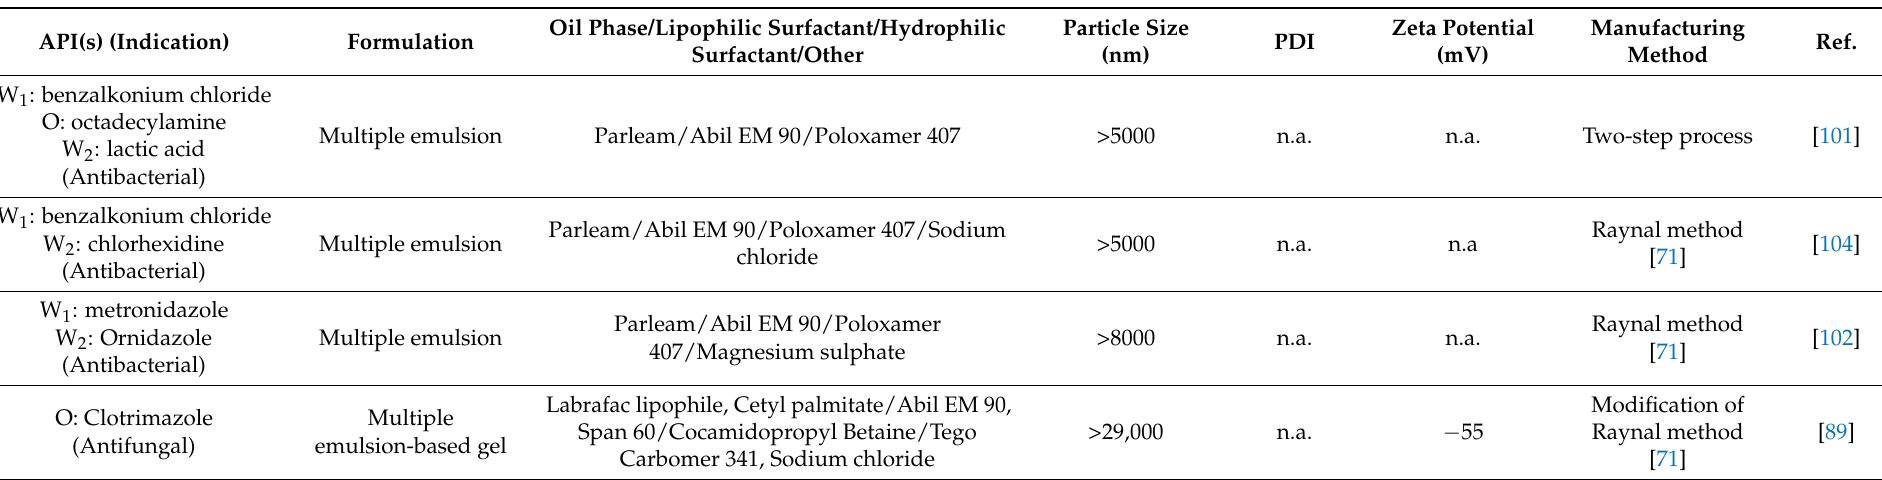
Table 5. Vaginal multiple emulsions—composition, characteristic properties and manufacturing